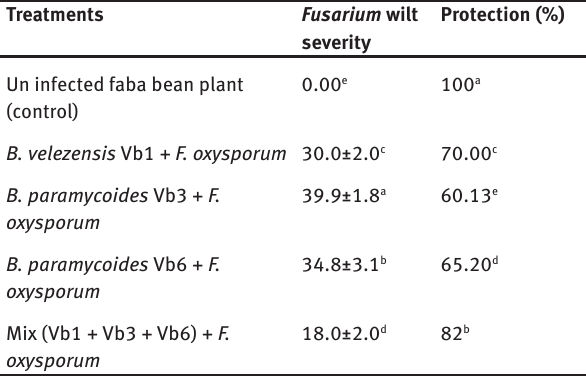
Table 3: Effect of rhizospheric bacterial strains Vb1, Vb3, and Vb6 on disease severity and protection of faba bean plants infected with Fusarium oxysporum under greenhouse